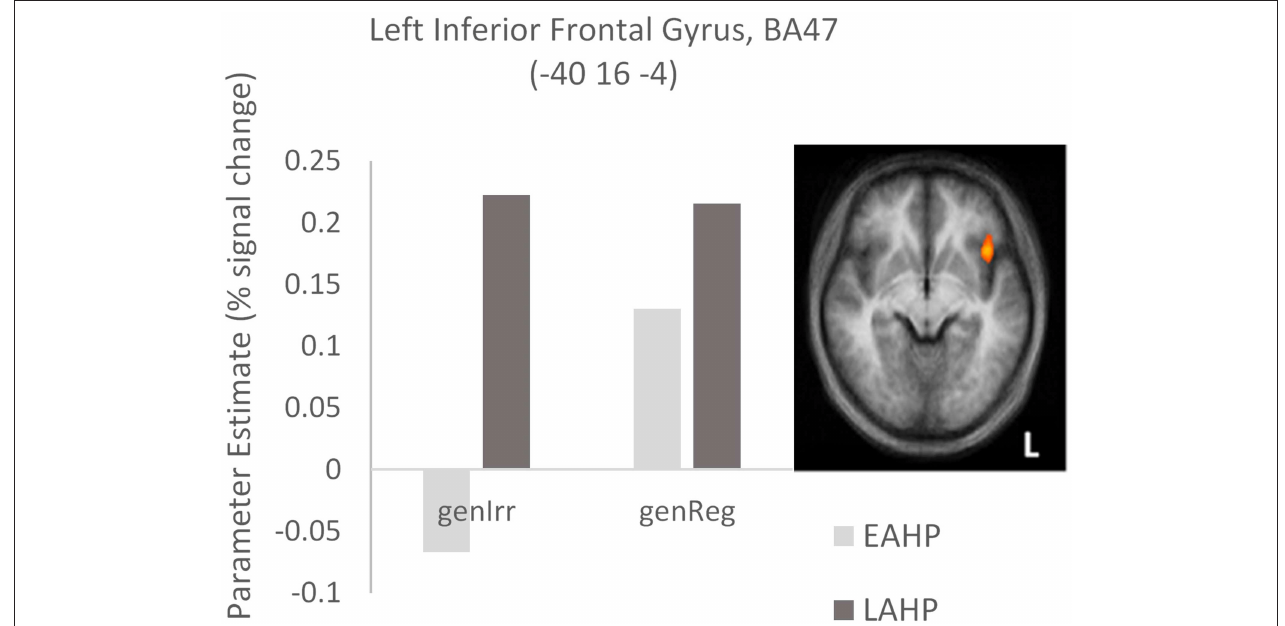
FIGURE 1 | Activation differences in BA47 between the early (EAHP) vs. late (LAHP) bilinguals for the Regularity × AoA condition. Significant activation is attributed to: (i) the difference between EAHP and LAHP for irregular inflection (left of the graph) and (ii) the difference between regular and irregular inflection for the EAHP bilinguals (see the lighter bars). Activated regions are those activated above the indicated threshold ( p < 0.05, corrected).